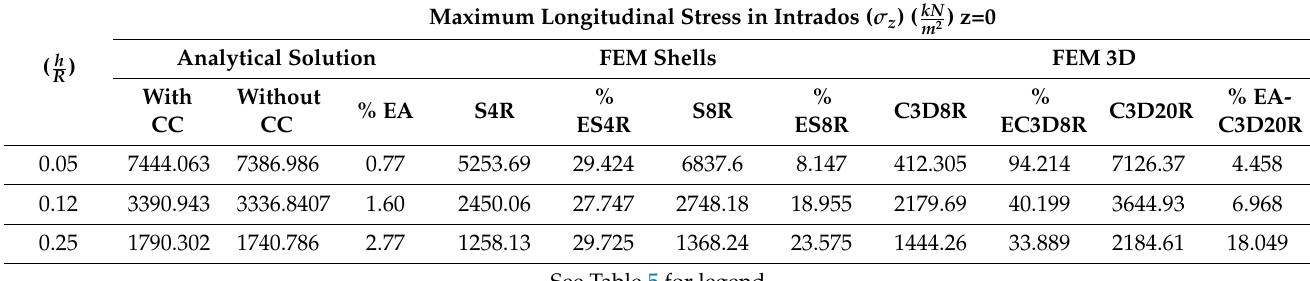
Table 8. Maximum longitudinal stress in intrados for different slenderness